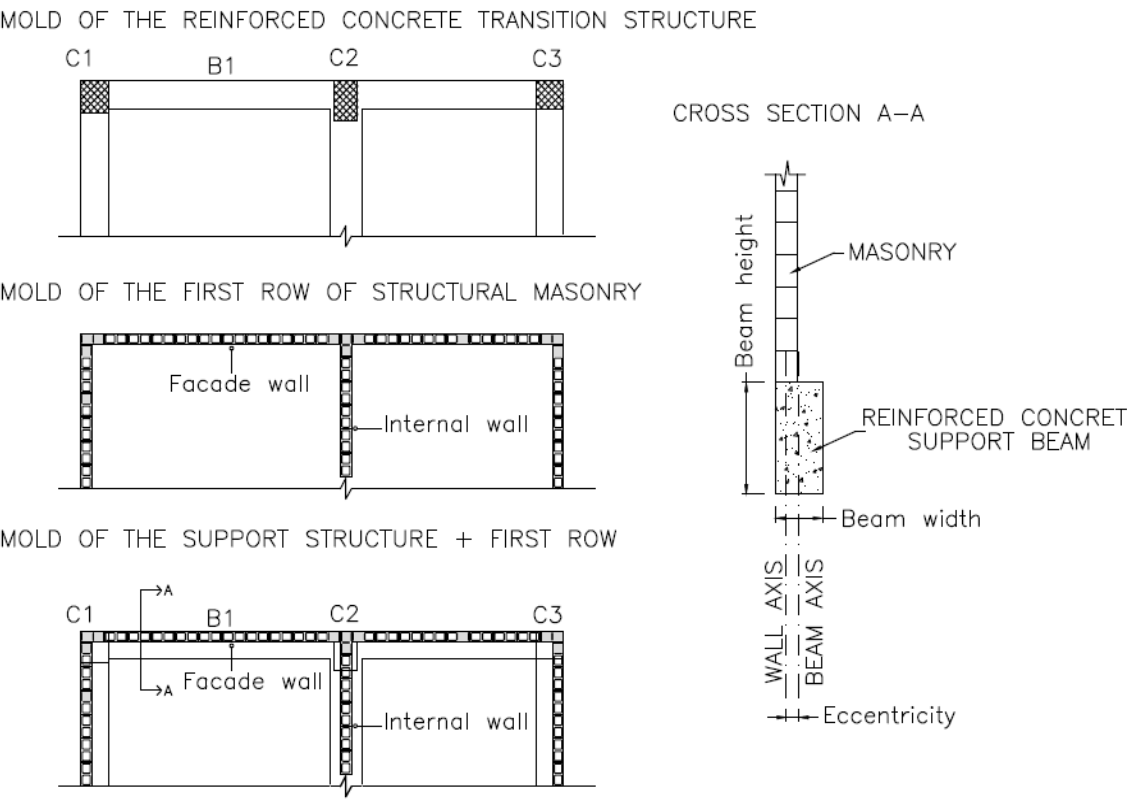
Figure 2. Layout of eccentricity between facade walls and support